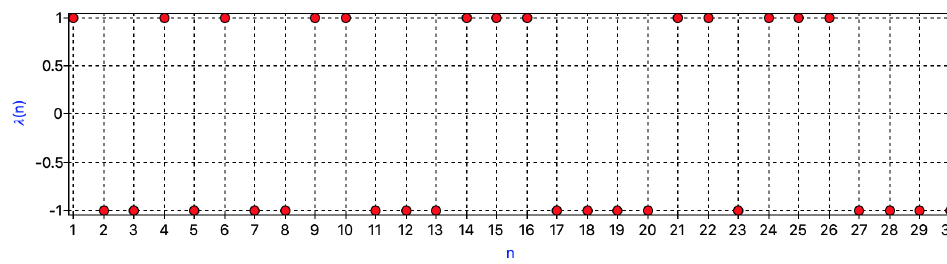
Figure 9. The simulation for λ ( n ) with 1 ≤ n ≤ 30.